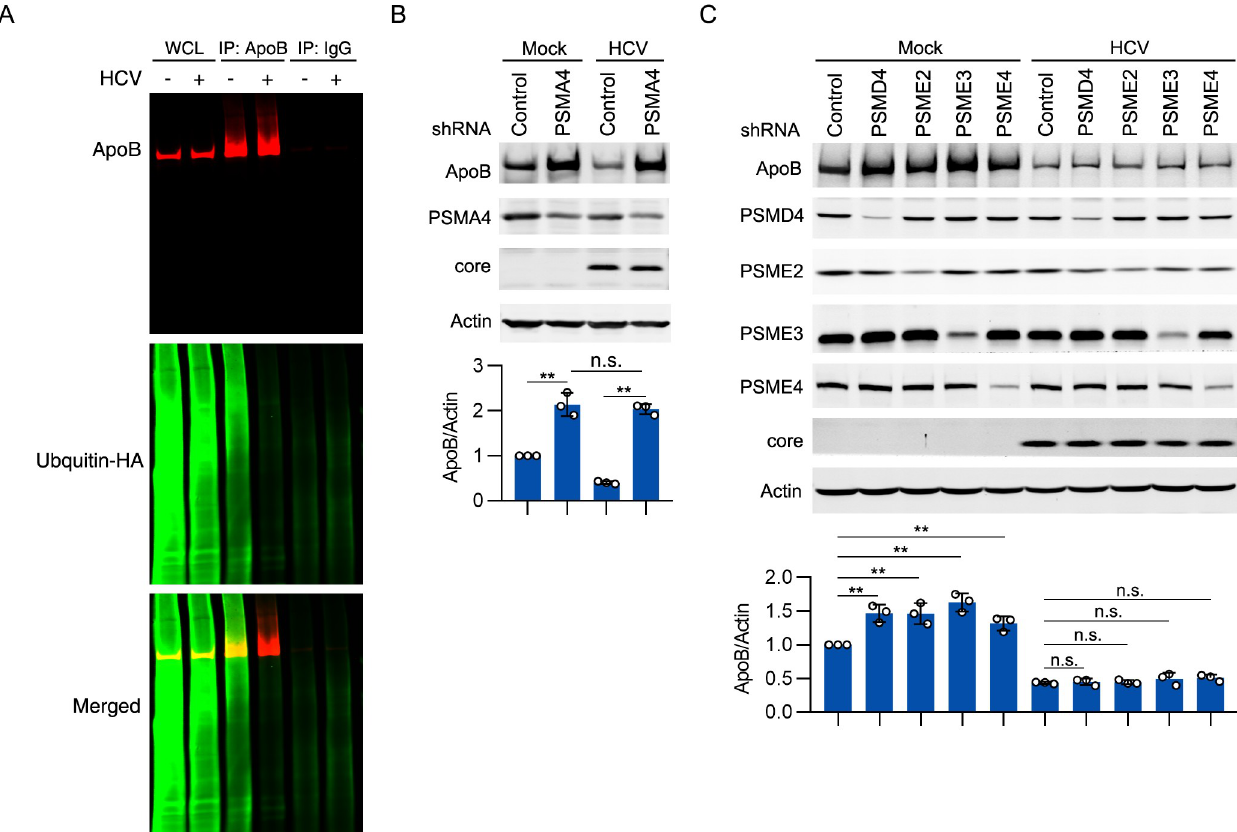
Fig 4. ApoB was degraded by the proteasome in a ubiquitin-independent manner in Huh-7 cells. (A) Huh-7 cells were infected with HCV (MOI = 1) for 2 days prior to transduction with HA-tagged ubiquitin (MOI = 1) for 2 days. At 4 days post HCV infection, the cells were treated with 10 μ M MG-132 for 12 hours. ApoB was immunoprecipitated under denaturing conditions, and the level of ubiquitin was analyzed by western blotting. WCL, whole-cell lysate. (B) Huh-7 cells were infected with HCV (MOI = 1) for 2 days prior to transduction with PSMA4 shRNA for 2 days. The protein levels of ApoB, PSMA4, and core proteins were analyzed by western blotting. Actin was used as the loading control. (C) Huh-7 cells were infected with HCV (MOI = 1) for 2 days prior to transduction with PSMD4, PSME2, PSME3, or PSME4 shRNA for 2 days. The protein levels of ApoB, PSMD4, PSME2, PSME3, PSME4, and core were analyzed by western blotting. Actin was used as the loading control. The data in B and C are presented as the means ± SDs from densitometry analyses of n = 3 independent experiments, and representative gels from each specific assay are shown. The statistical significance was determined by unpaired two- sided Student’s t -tests. n.s., not significant. �� P < 0.01.